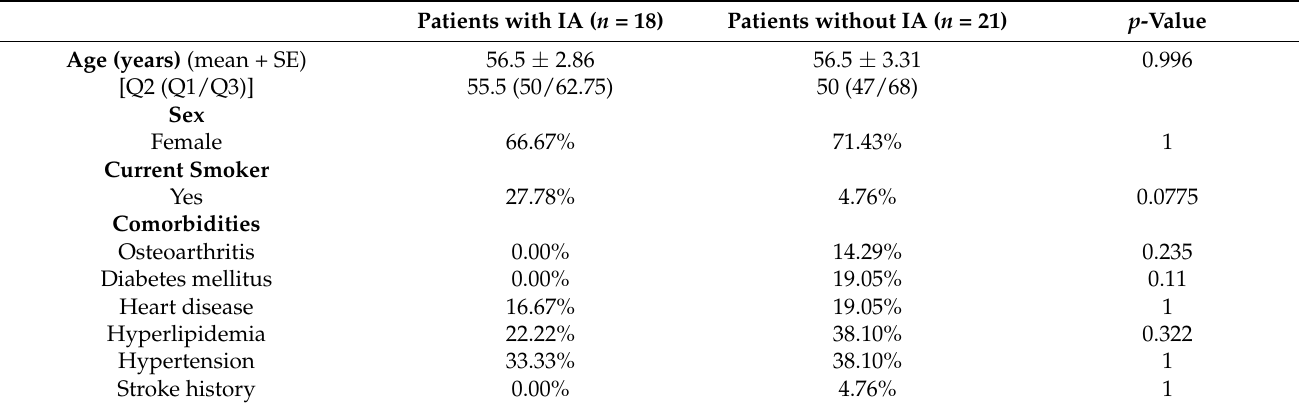
Table 1. Patient characteristics of the discovery cohort